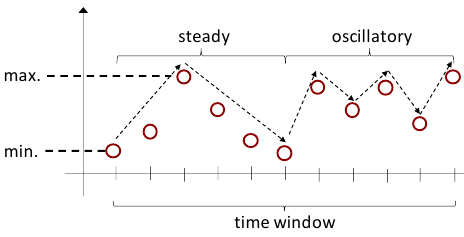
Figure 2. Variation patterns over time.